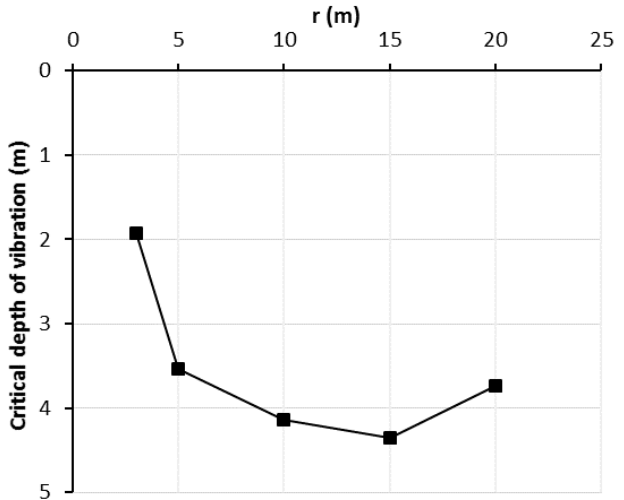
Fig. 8. Variation of the critical depth of vibration with radial distance from the pile axis